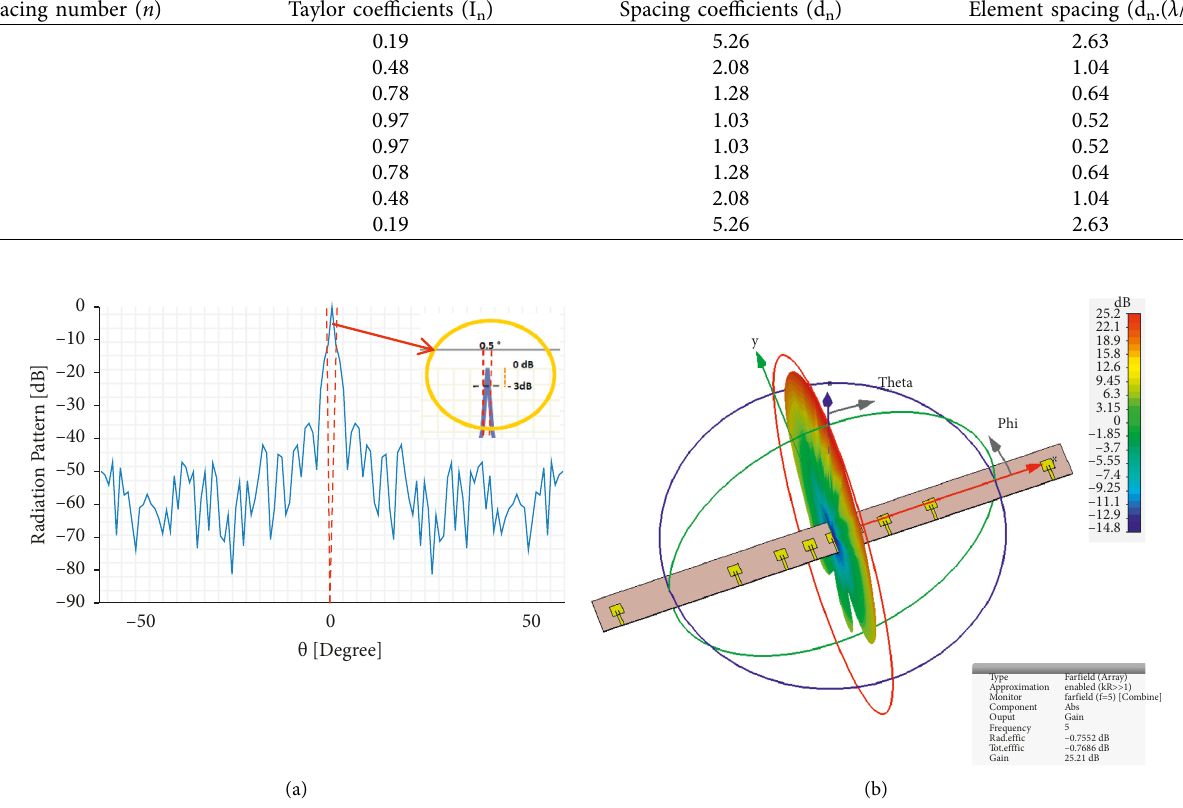
Figure 4: 9-Element sparse array configuration radiation pattern.